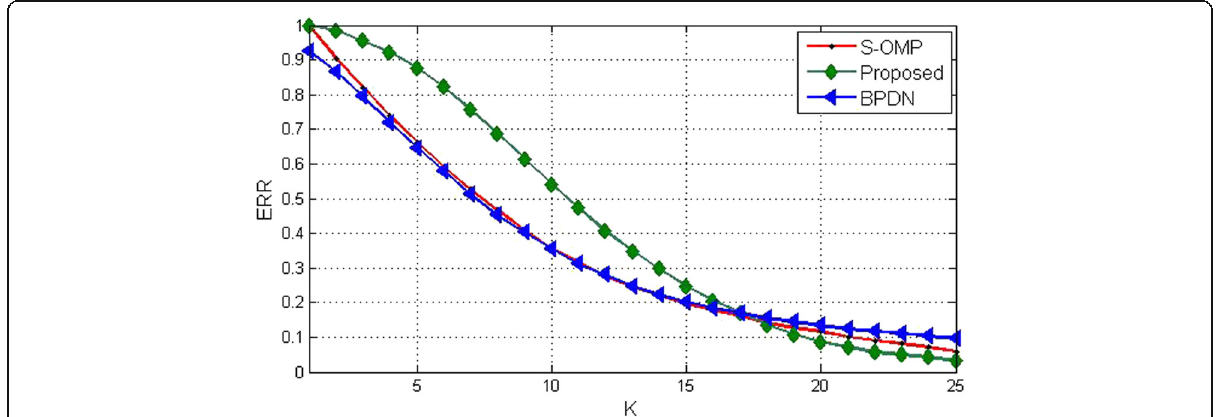
Fig. 2 Effect of increasing the number of sources ( K ) on ERR for SNR = 30 dB, L = 70, and M = 30